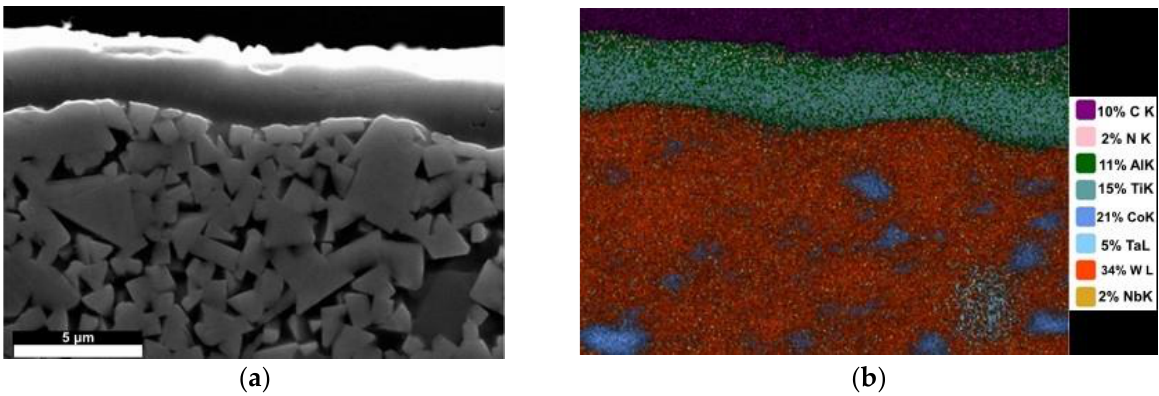
Figure 2. The SEM images of: ( a ) TiAlN – substrate interface; ( b ) TiAlN – substrate element overlay. Note. The upper magenta layer in ( b ) assigned to C is an instrumental artefact.